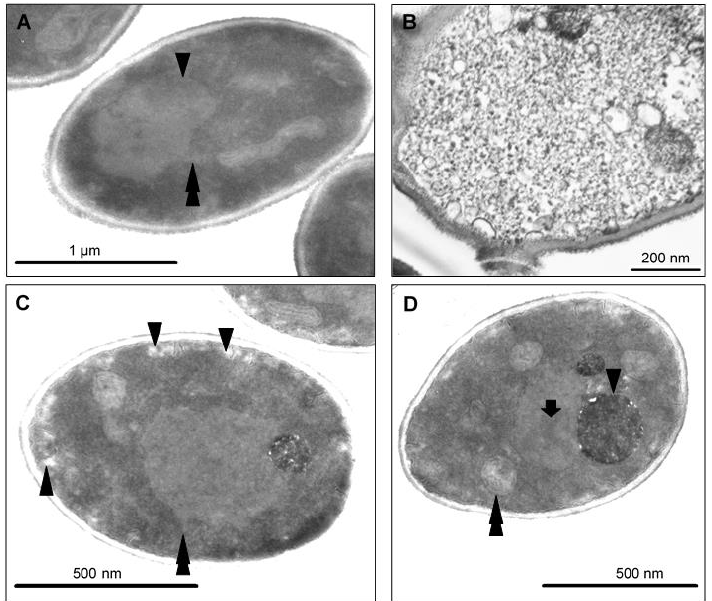
Figure 8. TEM micrographs of C. parapsilosis SZMC 8007 treated with a sub-lethal concentration of CAPE. Both apoptotic and necrotic cell structural changes were observed in samples. ( A ) Nuclear chromatin margination and condensation (arrowhead) and blebs (double arrowhead) detached from the nucleus are typical apoptotic hallmarks. ( B ) Few necrotic cells were also present. Note membrane disintegration, obvious vacuolization, and loss of cytoplasm density. ( C ) Peripheral vacuole formation refers to Golgi fragmentation and cell membrane separation from the cell wall (arrowheads). Nuclear blebs (double arrowhead). ( D ) Nuclear condensation (arrow) and extremely large lysosomal bodies (arrowhead). Note the swollen mitochondria (double arrowheads).